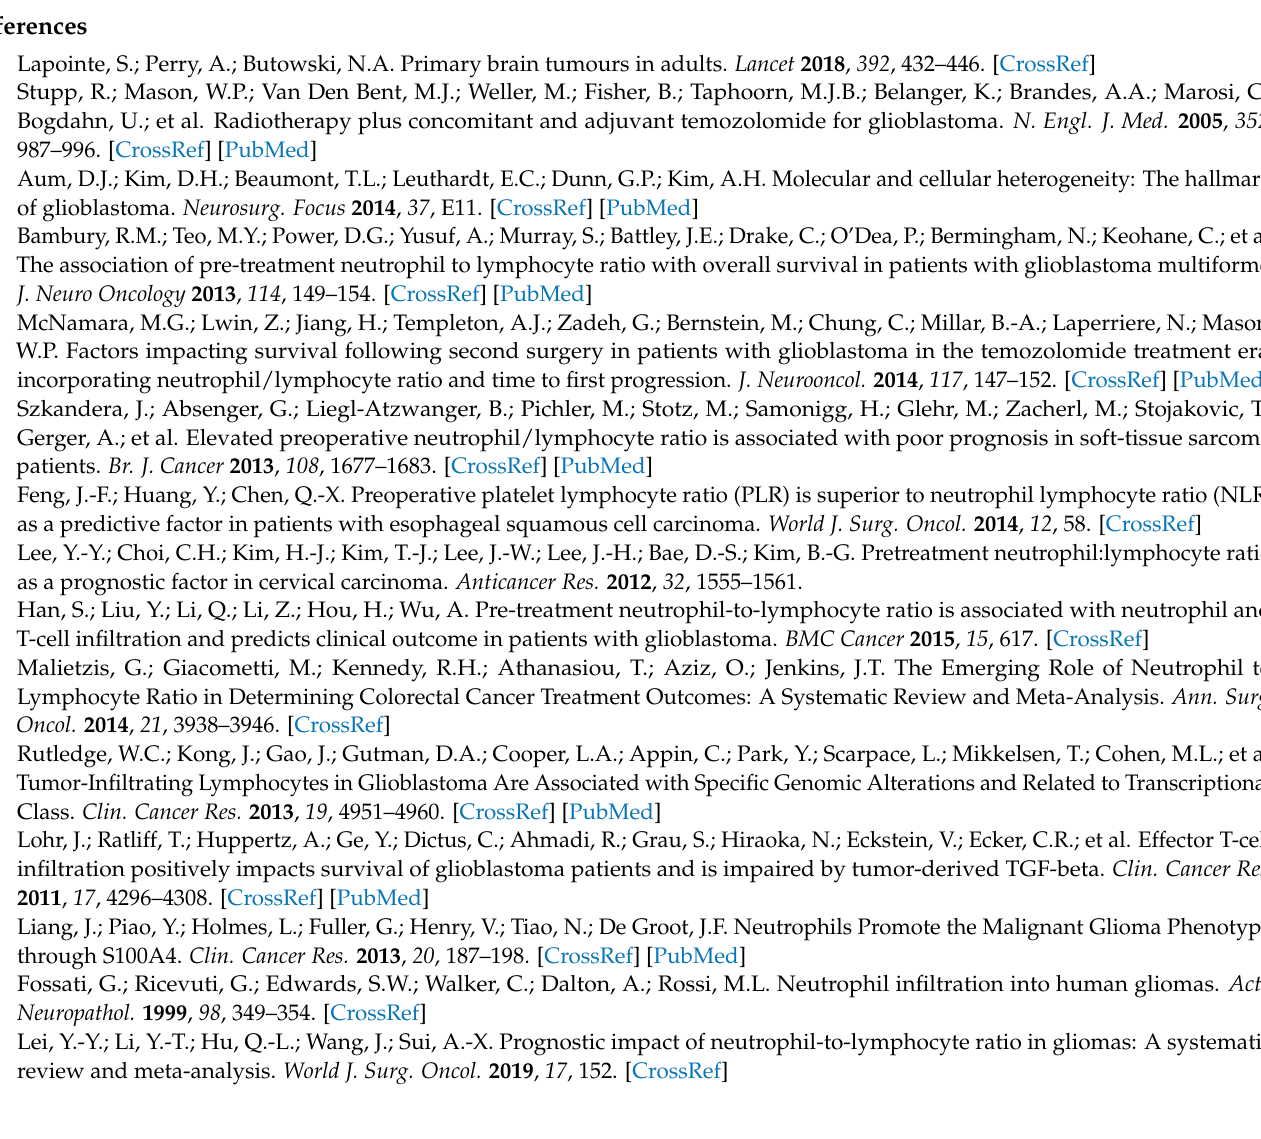
Figure A3. Quantitative analysis of publication bias using the Berger rank correlation method.